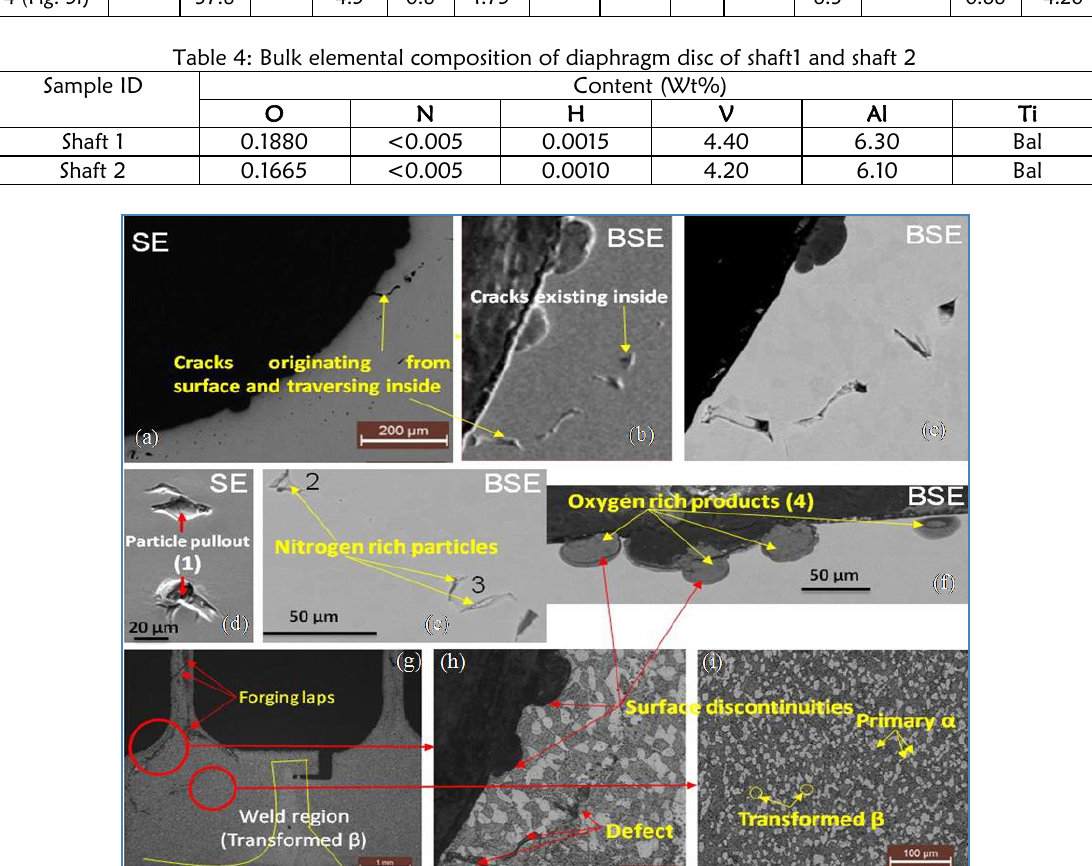
Fig. 8: Scanning electron micrographs of the rim portion of a typical outer surface cross-section of an outer diaphragm disc in SE and BSE modes - (a-f) unetched micrographs showing various defect types, (g-i) etched micrographs revealing forging laps more clearly. Etchant: Kroll’s